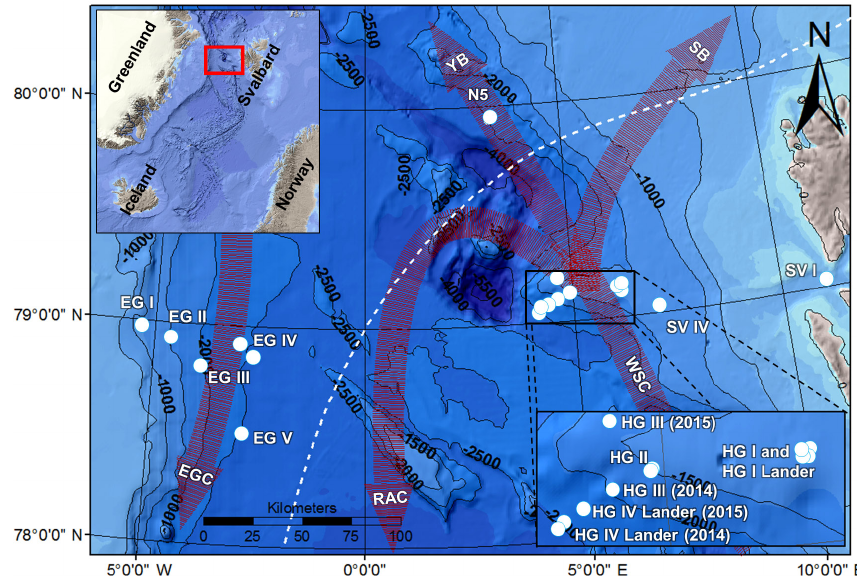
Figure 1. Locations of the sampled stations in the Arctic Fram Strait. White dashed line is the mean summer sea-ice extent in September over the period 1981–2010 (Walsh et al., 2015). Red arrows are the general current system. EGC is the East Greenland Current, WSC is the West Spitsbergen Current, SB is the Svalbard branch, YB is the Yermak branch, RAC is the Return Atlantic current. White dots are the stations with station names. More station-specific details are given in Table 1. Table 1. General station information regarding water depth, sampling date, location, and station ID in the data archive PANGAEA. The order of stations for each area follows the water depth